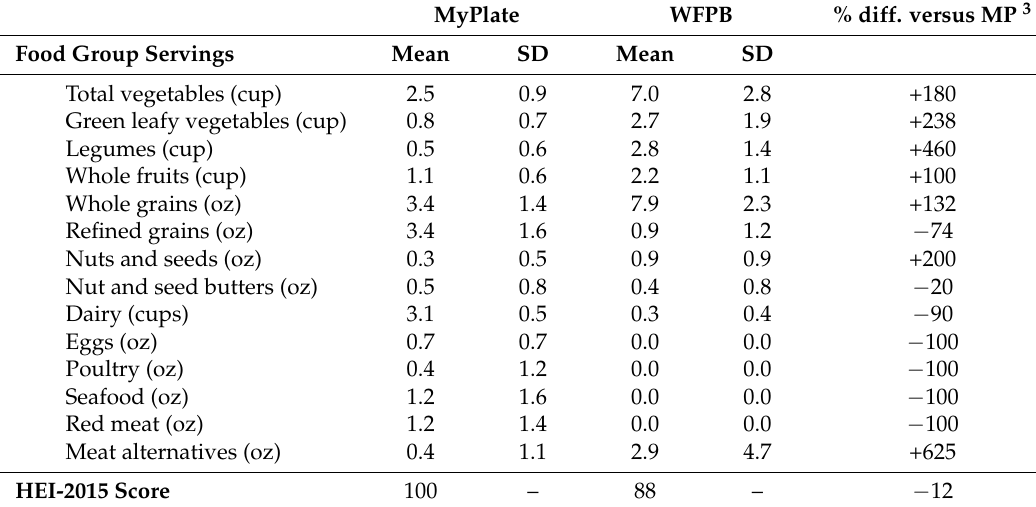
Table 1. Comparison of food intakes and diet quality for theoretical whole-food plant-based (WFPB) 1,2 meal plans compared to MyPlate 2